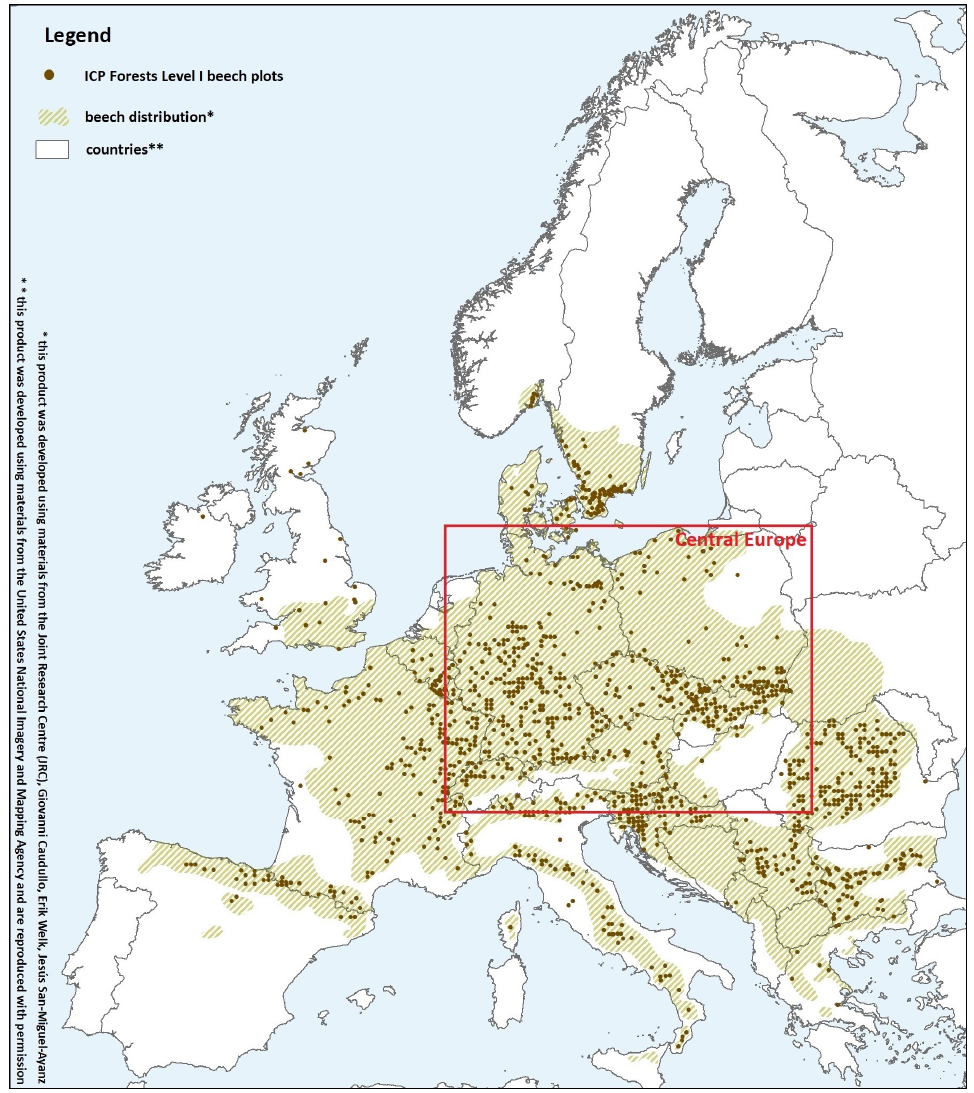
Figure 1. Distribution of European beech ( Fagus sylvatica L.) across Europe. Eight countries, viz. Austria, Czechia, Germany, Hungary, Poland, Slovakia, Slovenia, and Switzerland, are located in the Central European region. Brown dots are individual ICP Forests Level I beech plots. © Thünen Institute, 2022.